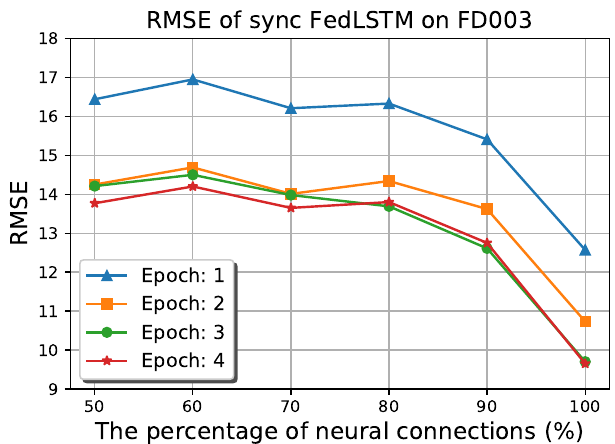
Figure 13. Results of random neural connection on synchronous FedLSTM.